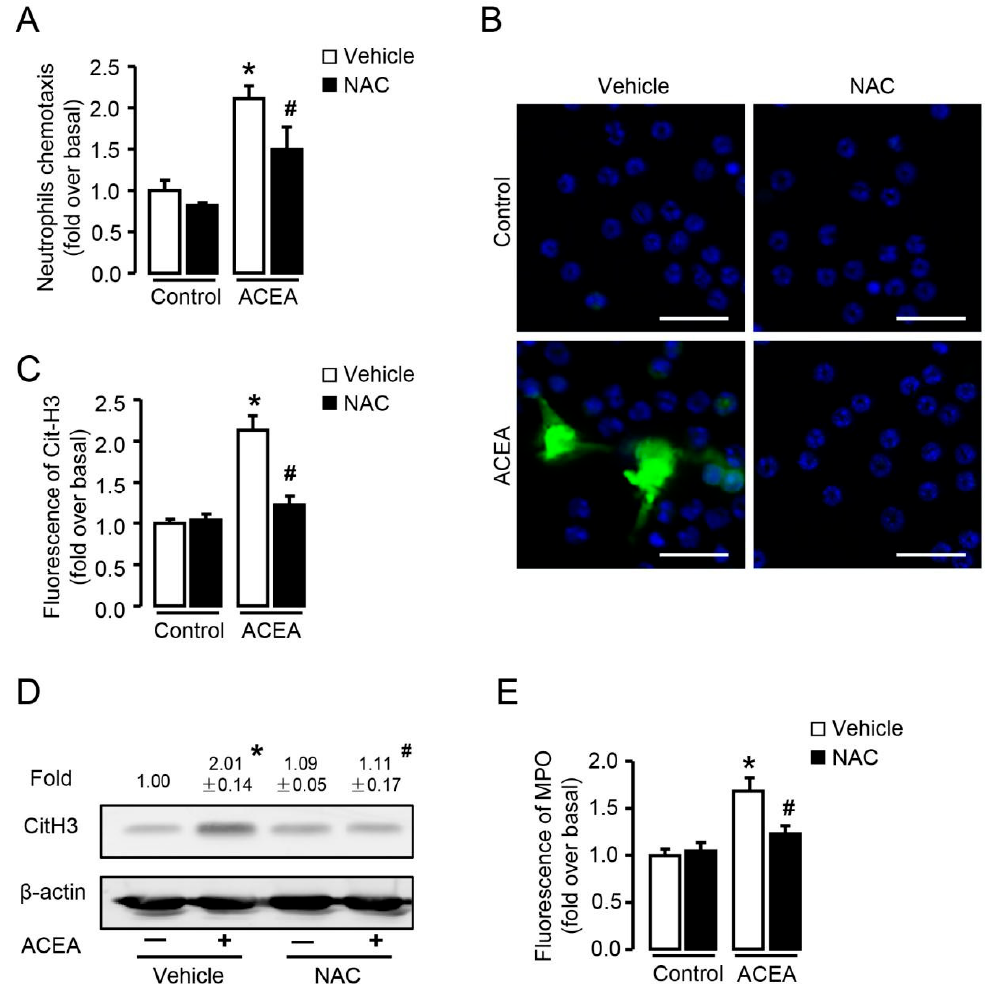
Figure 8. ROS is required in CB1-mediated chemotaxis and NETosis in vitro. ( A ) ACEA-induced neutrophil chemotaxis pretreated with or without NAC (5 mM). ( B , C ) Representative images and quantification of CitH3 immunofluorescent staining (green) and NETosis in ACEA-treated neutrophils pretreated with or without NAC. The nuclei were stained with DAPI (blue). Scale bars, 20 µm. ( D ) CitH3 protein level with or without NAC pretreatment was examined by Western blot. ( E ) Quantification of MPO immunofluorescence with or without NAC pretreatment. Data are presented as the mean ± SEM. N = 4 per group. * P < 0.05 vs. control. # P < 0.05 vs. ACEA-treated alone.